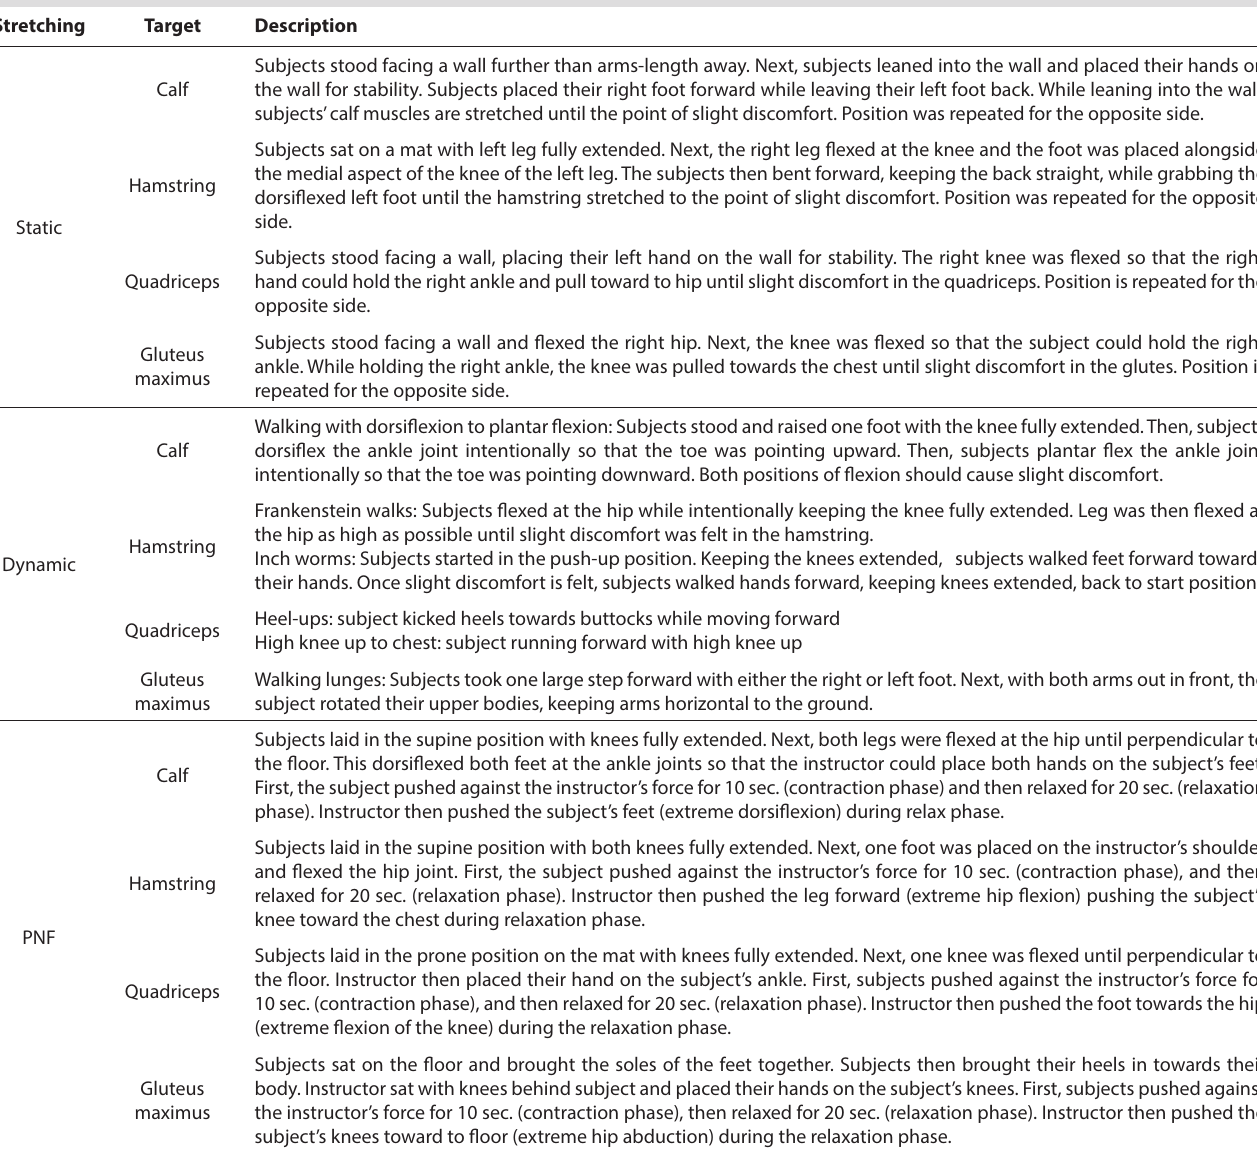
Stretching Target